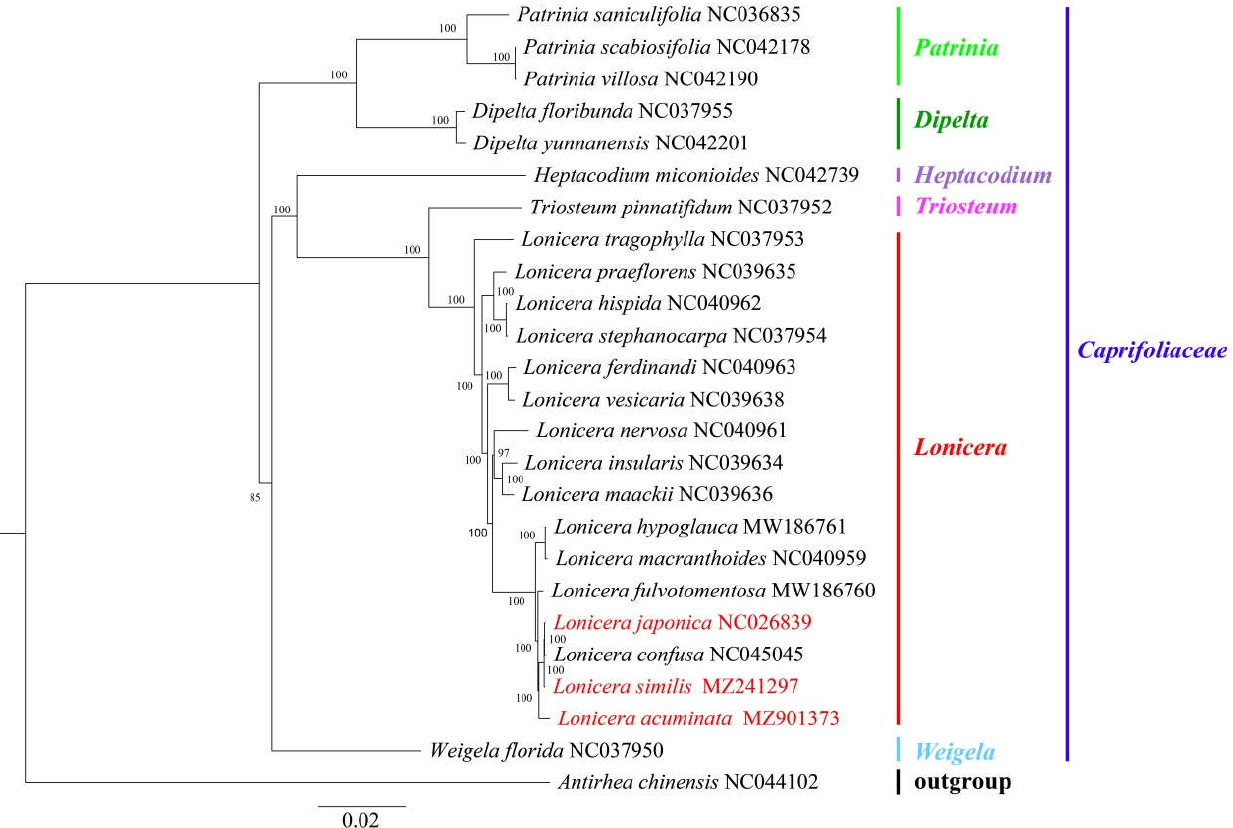
Figure 7. Maximum-likelihood tree based on the complete chloroplast genome sequences of 25 species. GenBank accession numbers are described in the figure. Shown next to the nodes are bootstrap support values based on 1000 replicates.